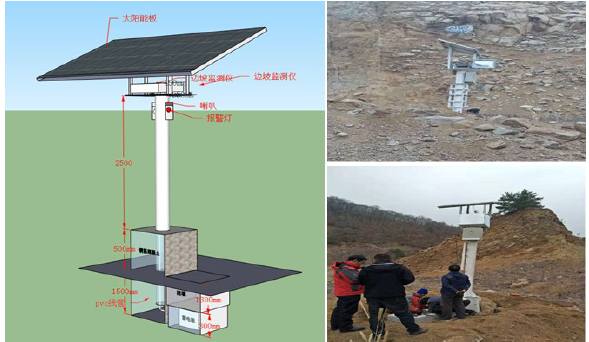
Figure 7. Design structure and field installation status of the Video Monitor for Geological Deformation of the